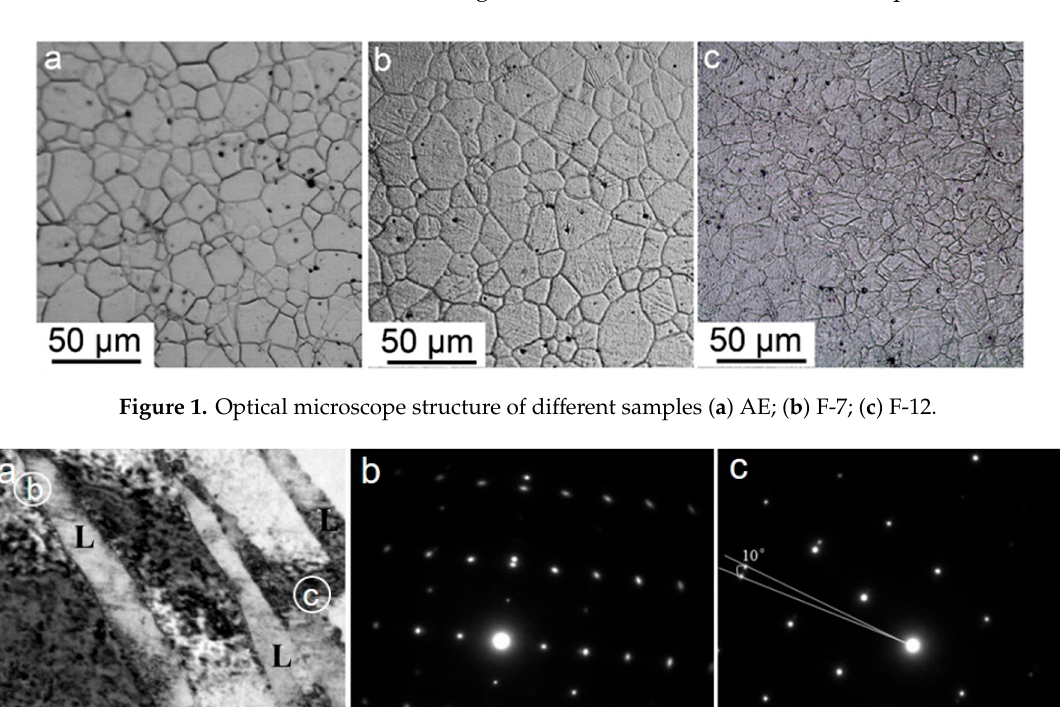
Figure 1. Optical microscope structure of different samples ( a ) AE; ( b ) F-7; ( c ) F-12.